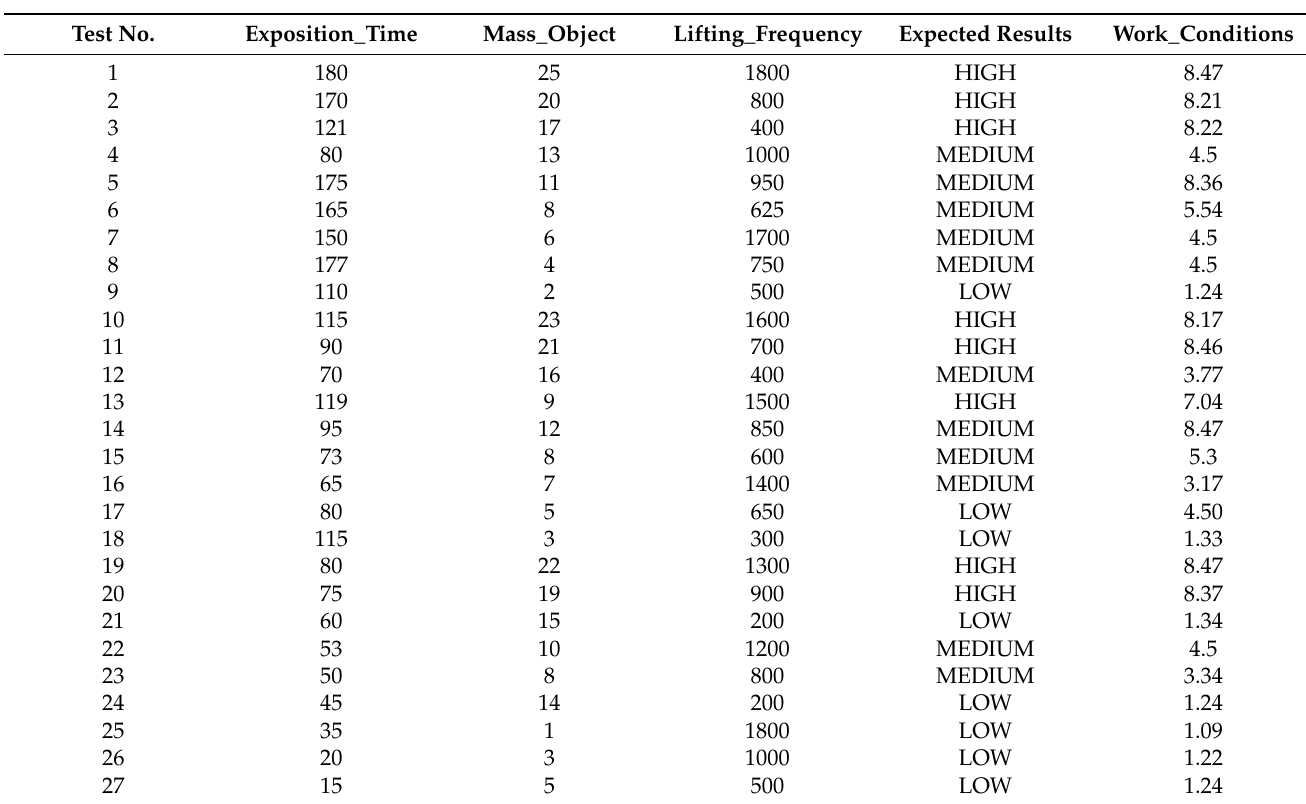
Table 9. Comparison of expected results concerning fuzzy interface